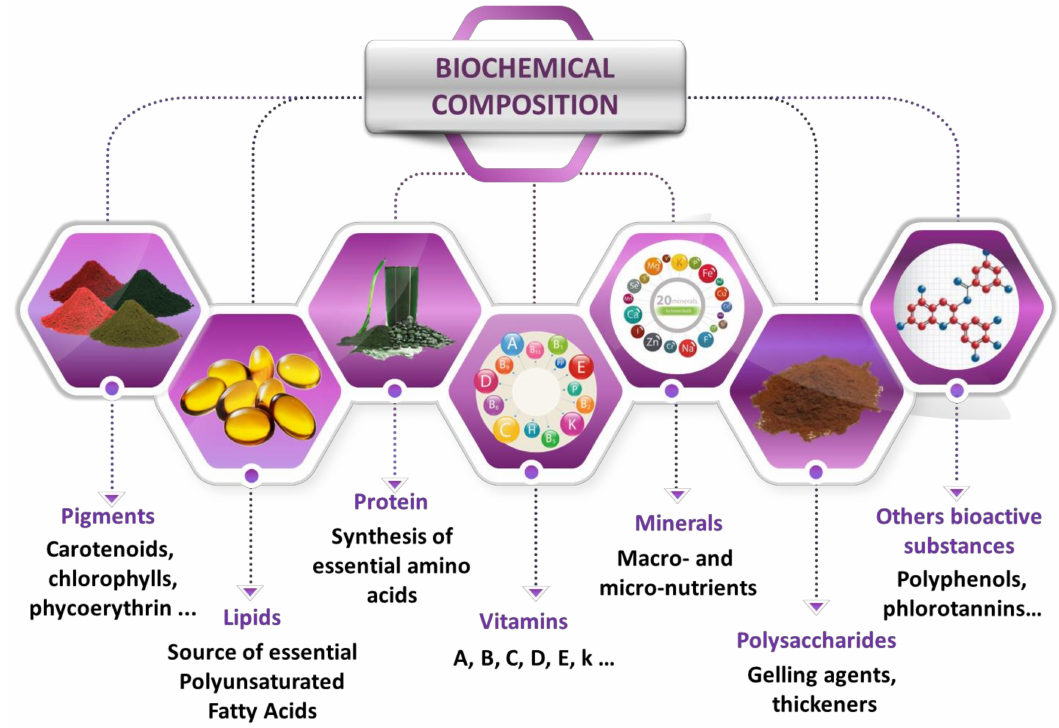
Figure 1. Bioactive compounds from marine